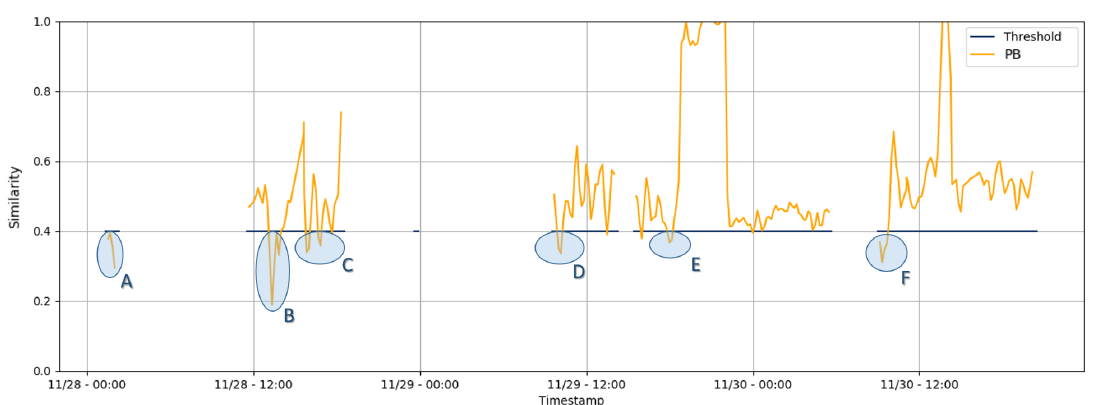
Figure 11. Predominant behavior of user E during a full work week, highlighting unexpected behavior